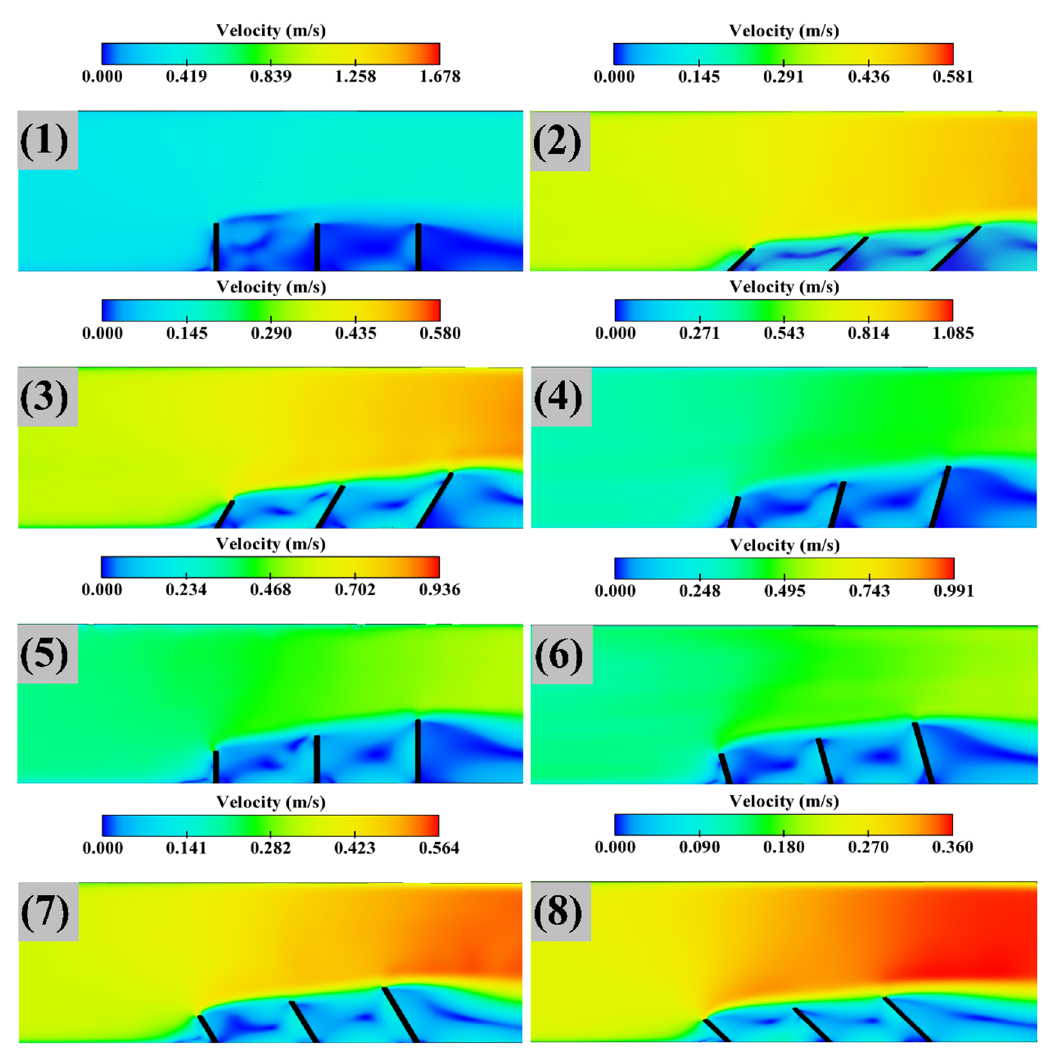
Figure 14. Velocities in 1–8 simulation.